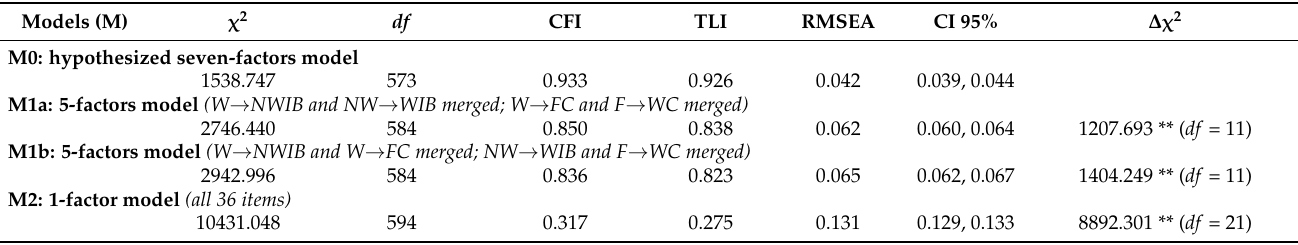
Table 2. Results of confirmatory factor analysis and alternative model comparisons.